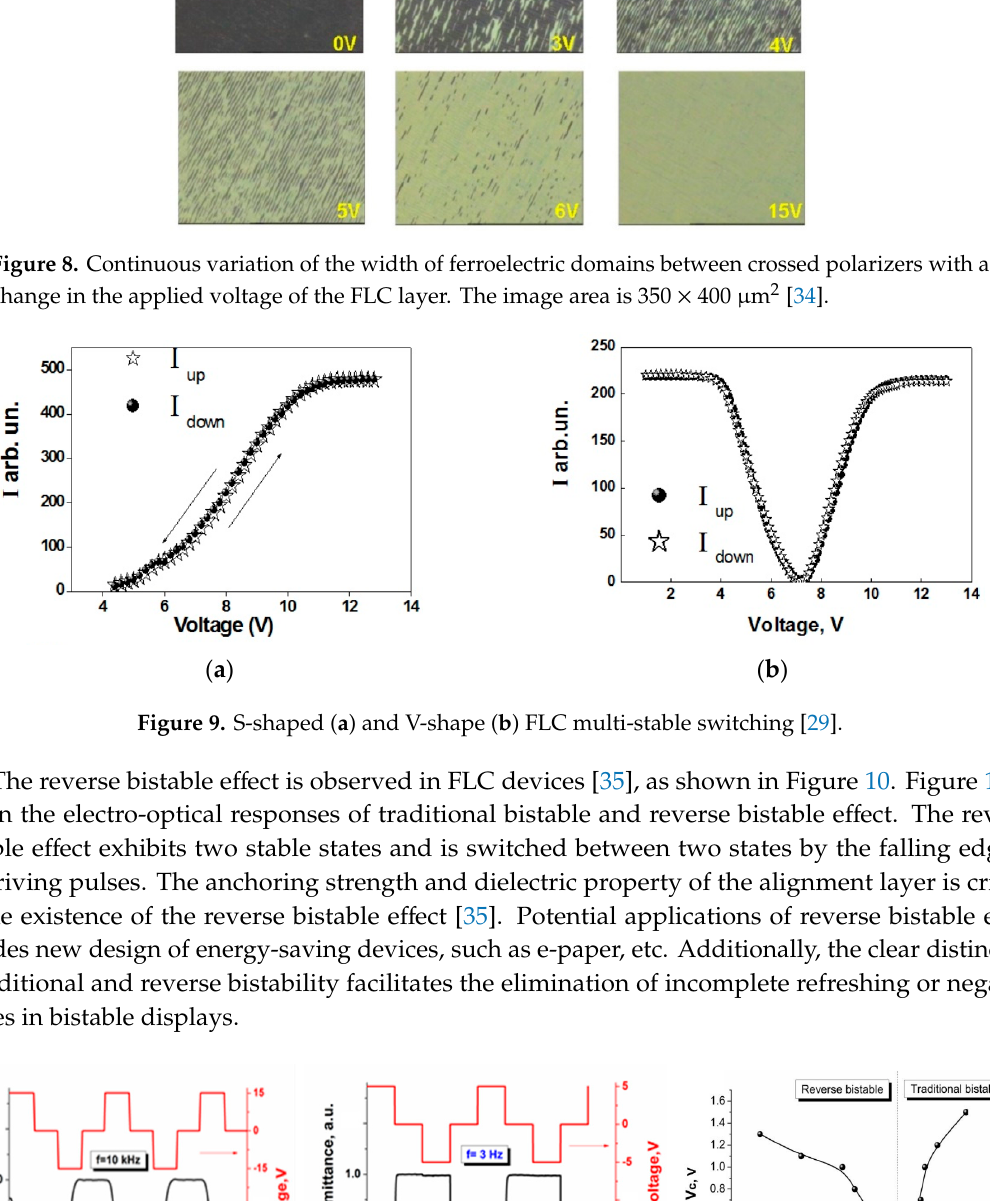
Crystals 2019 , 9 , 470 Figure 8. Continuous variation of the width of ferroelectric domains between crossed polarizers with a change in the applied voltage of the FLC layer. The image area is 350 × 400 μ m 2 [34].